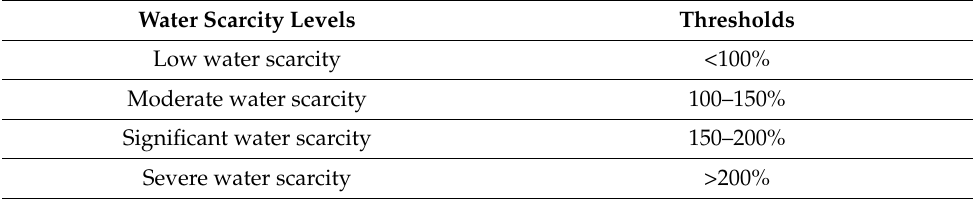
Figure 8. Blue water scarcity in Peshawar Basin (1986–2015). Table 3. Classification of blue water scarcity [65].